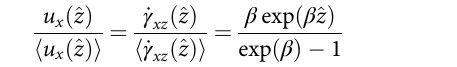
S r , according to the depth-dependent grain velocity, u x ð ^ z Þ , normalized by the vertical average of grain velocities, u x ^ z ð Þh i (Eq. (3)).